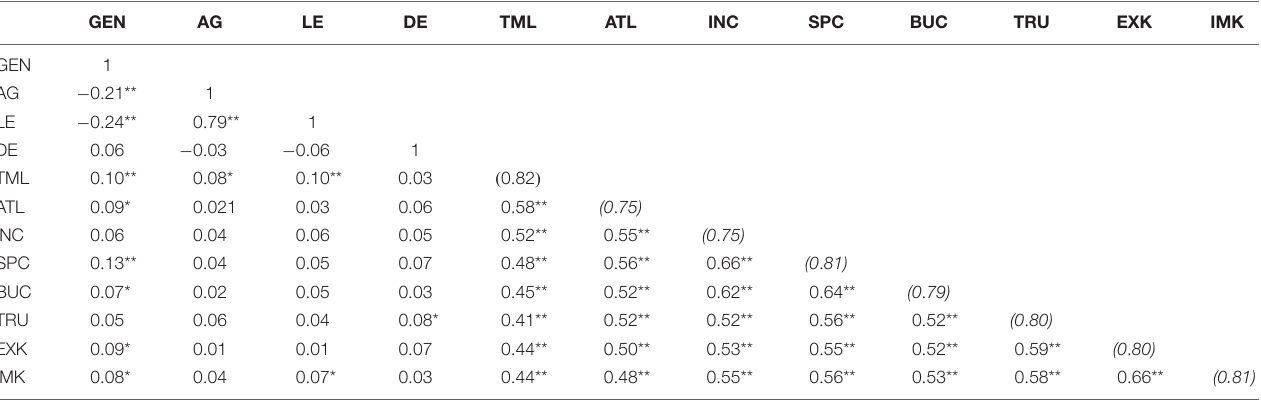
TABLE 1 | Correlation coefficient matrix of the variables and discriminant validity. GEN AG LE DE TML ATL INC SPC BUC TRU EXK IMK